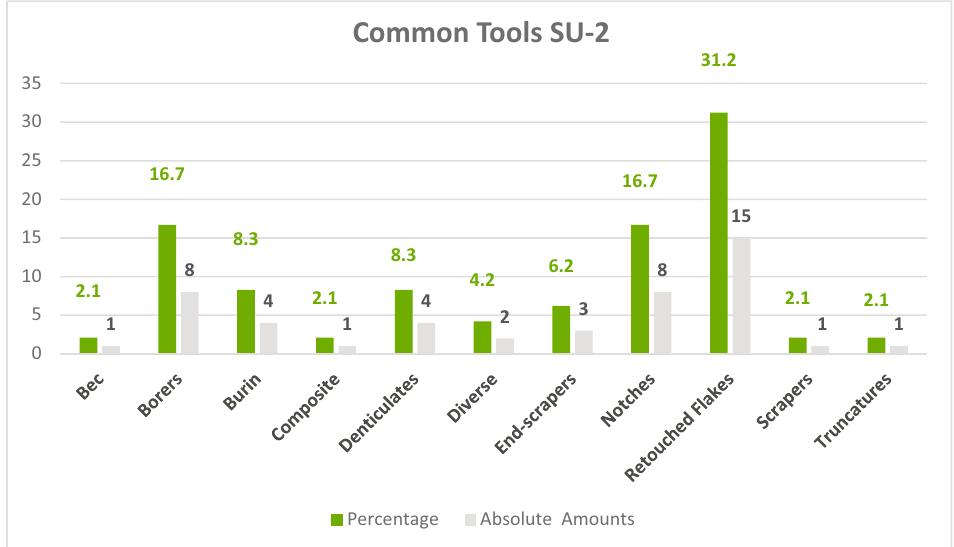
Figure 9: Common tools SU - 2 ( percentage and absolute amounts )